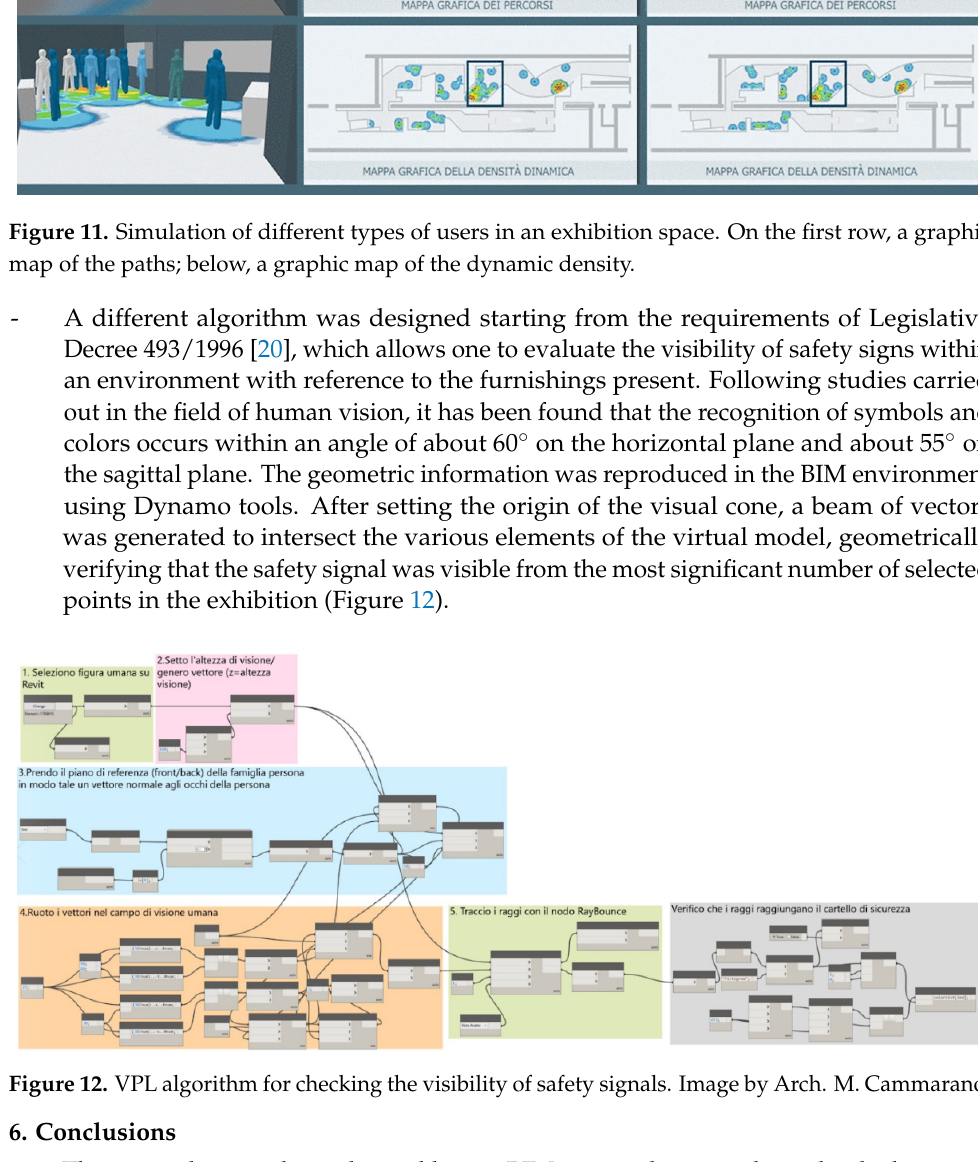
Figure 12. VPL algorithm for checking the visibility of safety signals. Image by Arch. M.